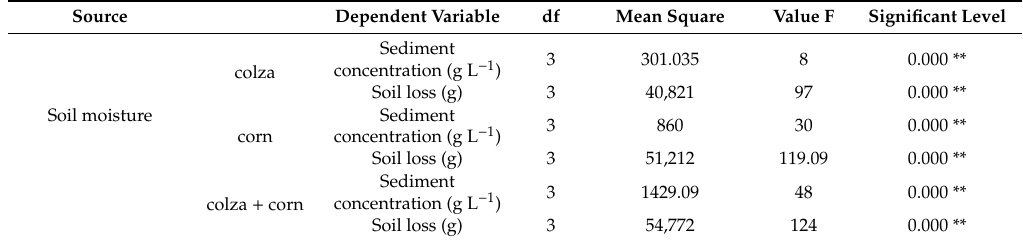
Table 2. General linear model test after applying the one way and two-way ANOVAs per soil moisture condition and straw mulch application, considering soil loss and sediment